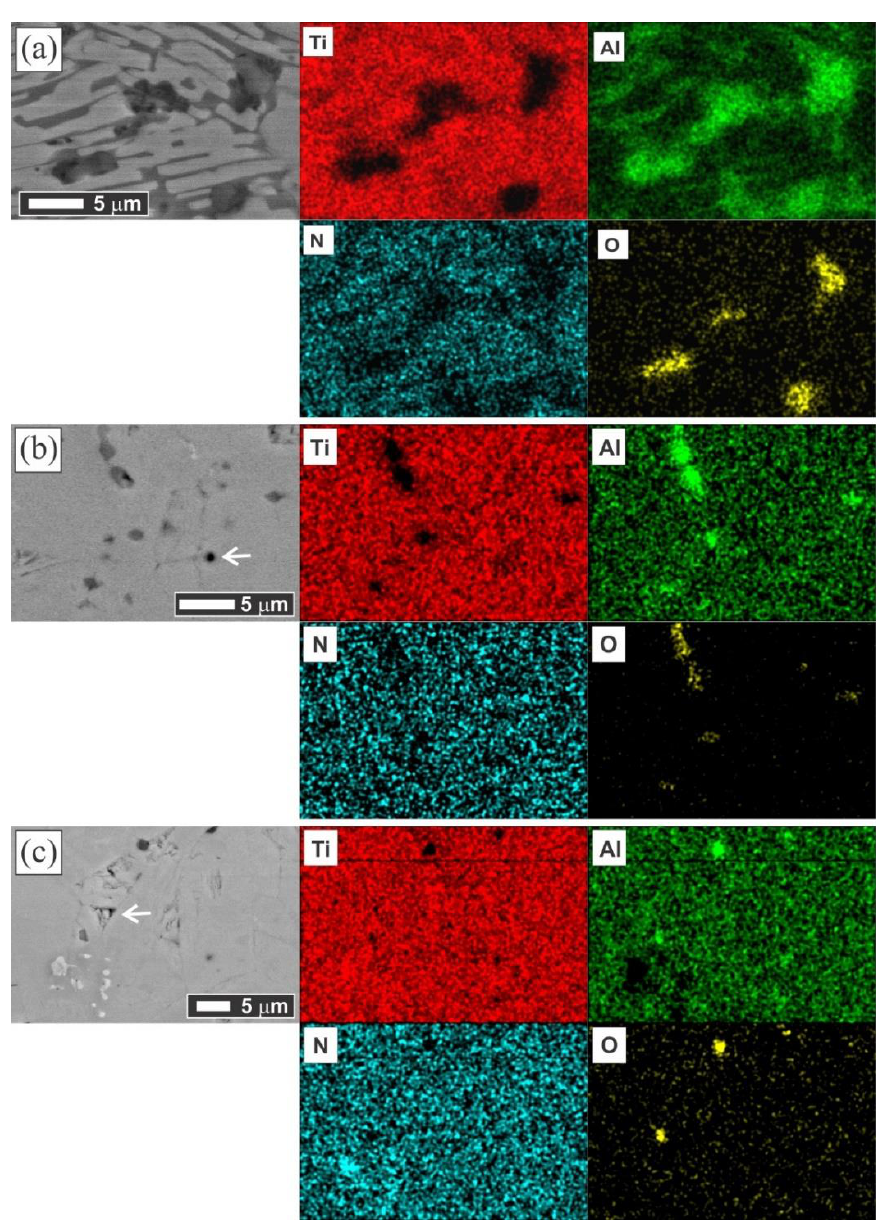
Figure 4. SEM images of the polished and non-etched samples with the elemental maps of the same area for the Ti (red), Al (light green), N (light blue) and O (yellow) for the ( a ) outer border zone of MAX-1200, ( b ) MAX-1200 middle zone and ( c ) MAX-1300 middle